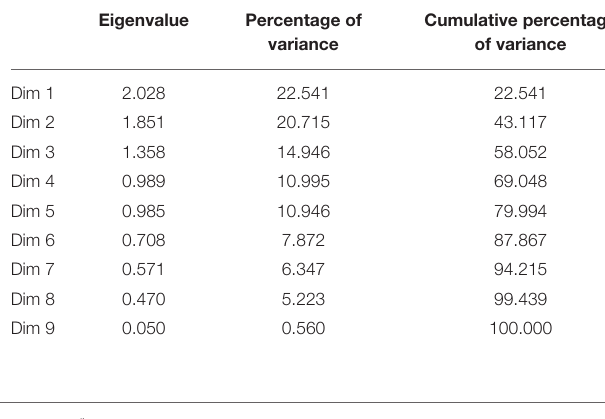
variability in veterinary practices explained in each synthetic dimension.